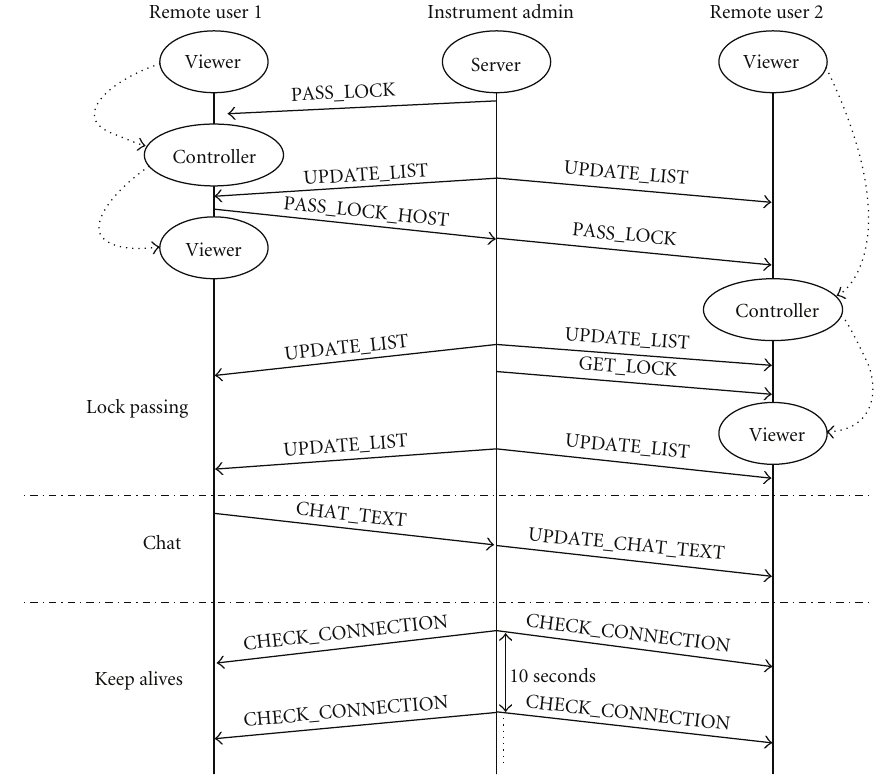
Figure 20: RICE’s Session Signaling Protocol in-session